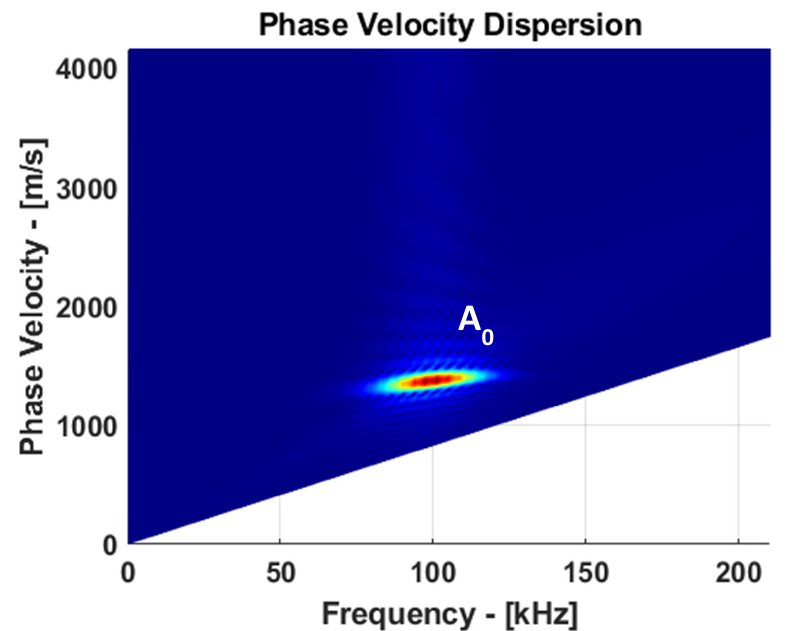
Figure 5. Guided wave A 0 mode phase velocity dispersion at 100 kHz.